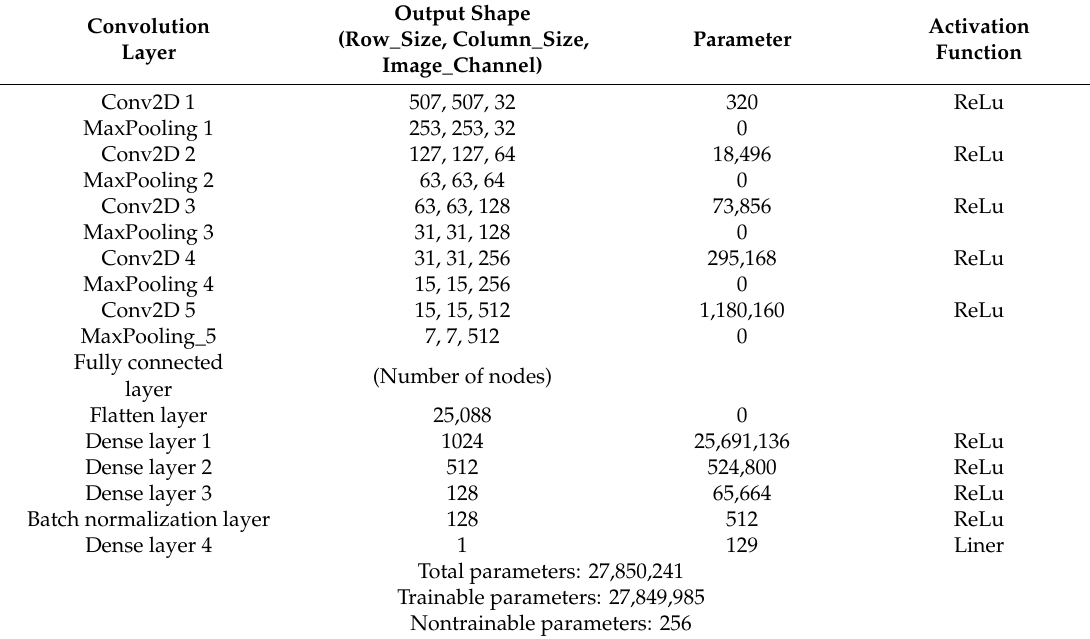
Table 5. Summary of the study